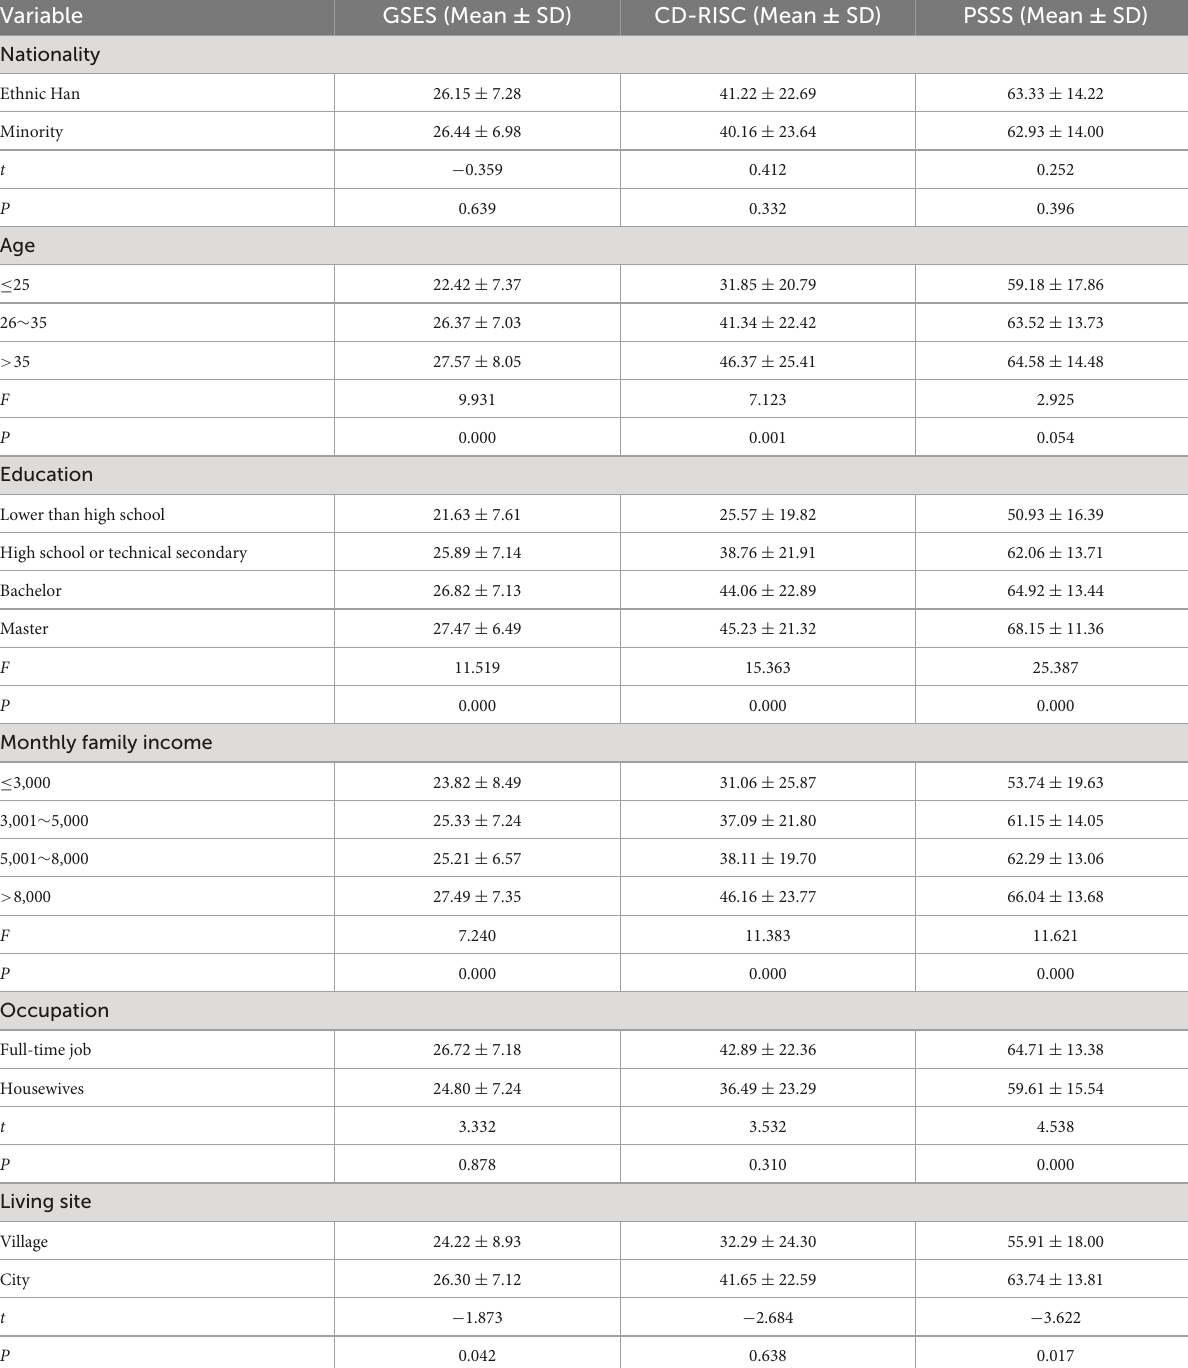
TABLE 2 The positive psychological level of the pregnant women assessed in this study.